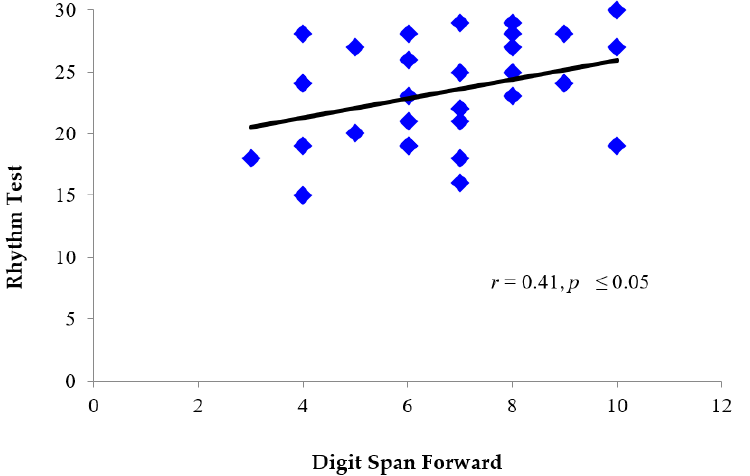
Figure 6. Individual scores for TBI patients depicting the relationship between performance on the MBEA Rhythm test (total score) and digit span forward (scaled score). Patients who performed better on the Rhythm test also tended to perform better on Digit Span Forward.